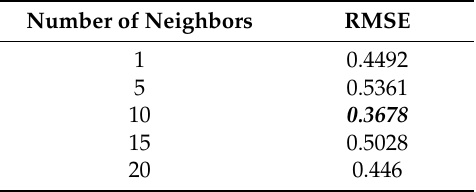
Table A2. Sensitivity of locally-weighted learning (LWL) to the number of neighbors.